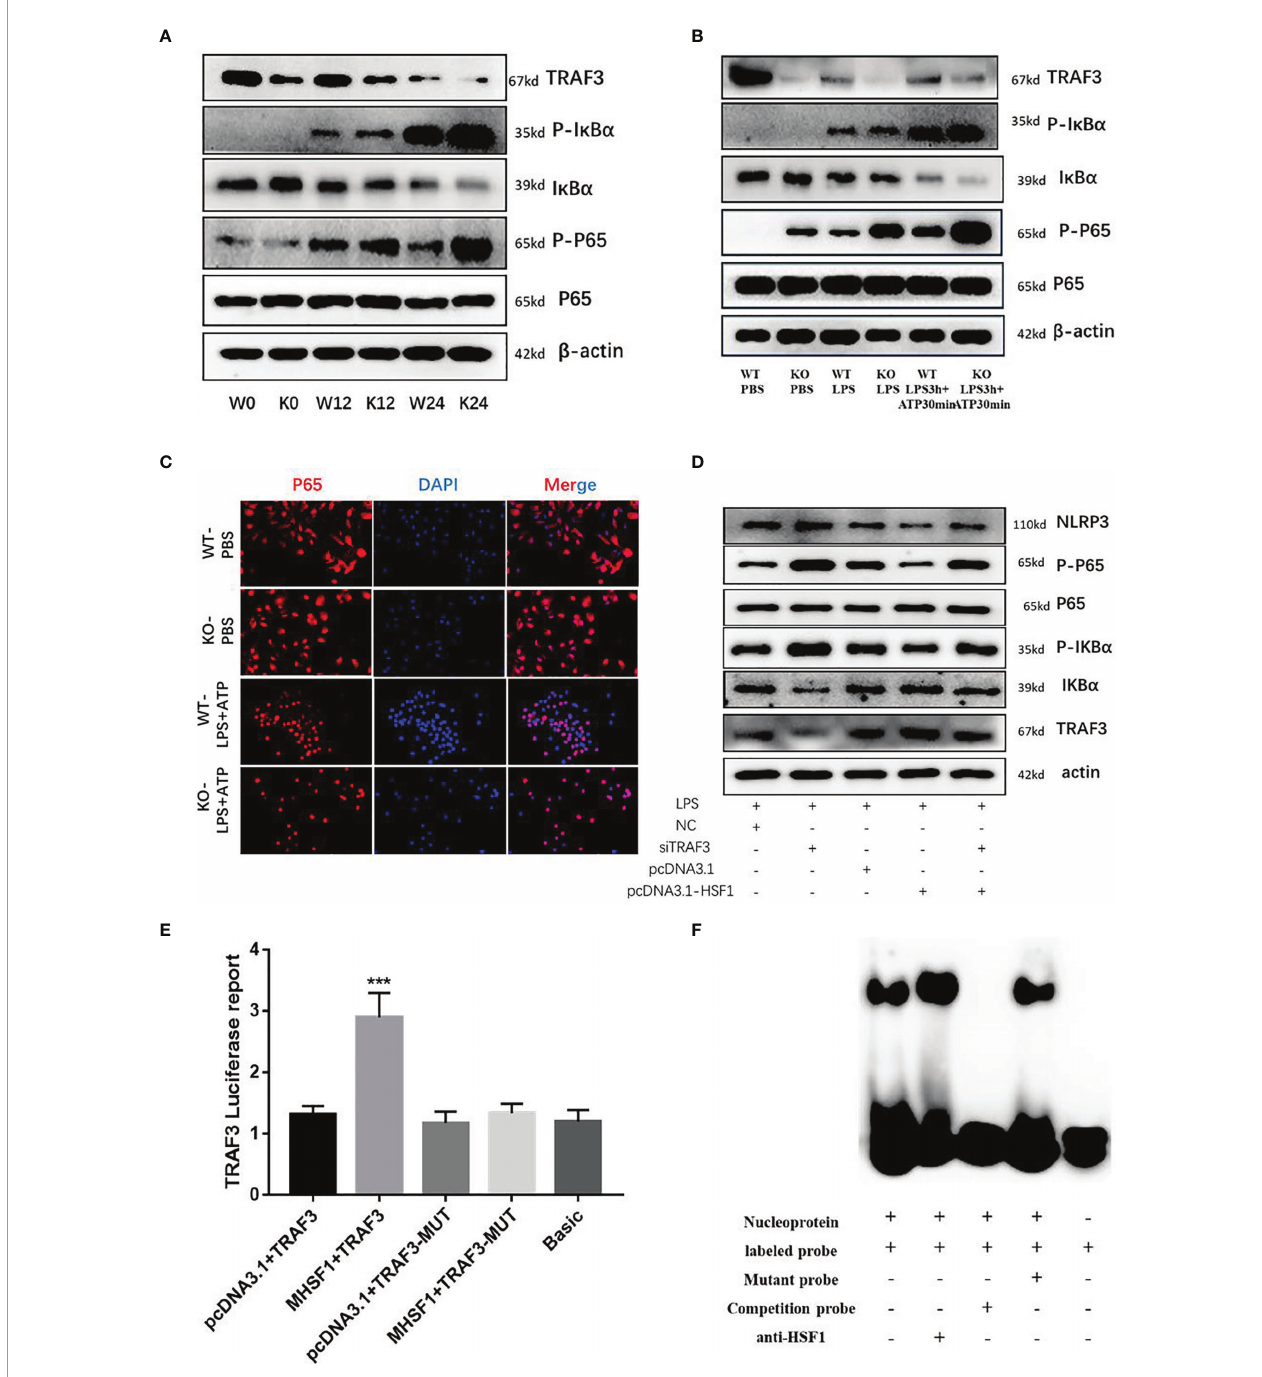
FIGURE 4 | HSF1 inhibits the activation of NF- k B signaling pathway by upregulating TRAF3 expression. (A) Western blotting detected the expression of NF- k B pathway-related proteins in the lung tissues of septic mice. (B) Western blotting detected the expression of NF- k B pathway-related proteins in LPS3h (100 ng/ml), and ATP (2.5 mM) induced primary peritoneal macrophages of mice. (C) Immuno fl uorescence was used to detect the nucleation of P65 under different treatment conditions. (D) Western blotting detected the expression of NF- k B pathway-related proteins in RAW264.7 cells transfected with pcDNA3.1-HSF1 and siTRAF3. (E) The transcriptional regulation of HSF1 on TRAF3 was detected by dual-luciferase reporter genes. (F) The combination of HSF1 and TRAF3 was detected by EMSA. Data are representative or means (SD) of at least three independent experiments. Statistical analyses were determined using a Student ’ s t -test. ***p < 0.001, compared with the control (pcDNA3.1+TRAF3). LPS, lipopolysaccharide; EMSA, electrophoretic mobility shift